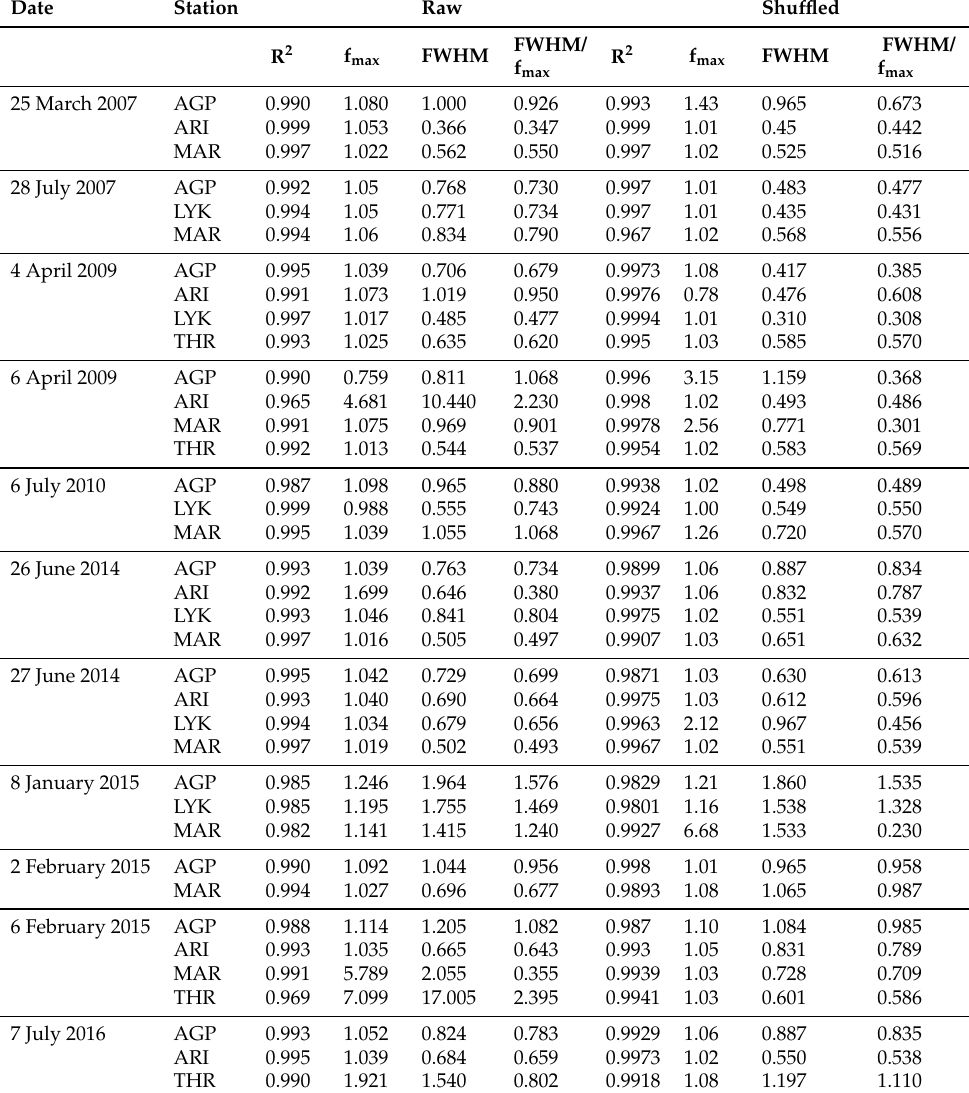
Table 3. MFDFA results of the 11 date-periods of Table 2. In these date-periods, according to Nikolopoulos et al. [32], the following facts happen simultaneously: (a) the PM 10 is out of stochastic behaviour, (b) BE is below 2.0 and TE below 1.18 and (c) points a and b are commonly found by 3 or more monitoring stations of Table 1. For calculations of FWHM and f max , the reader should refer to text. R 2 is the square of the adjusted coefficient of each